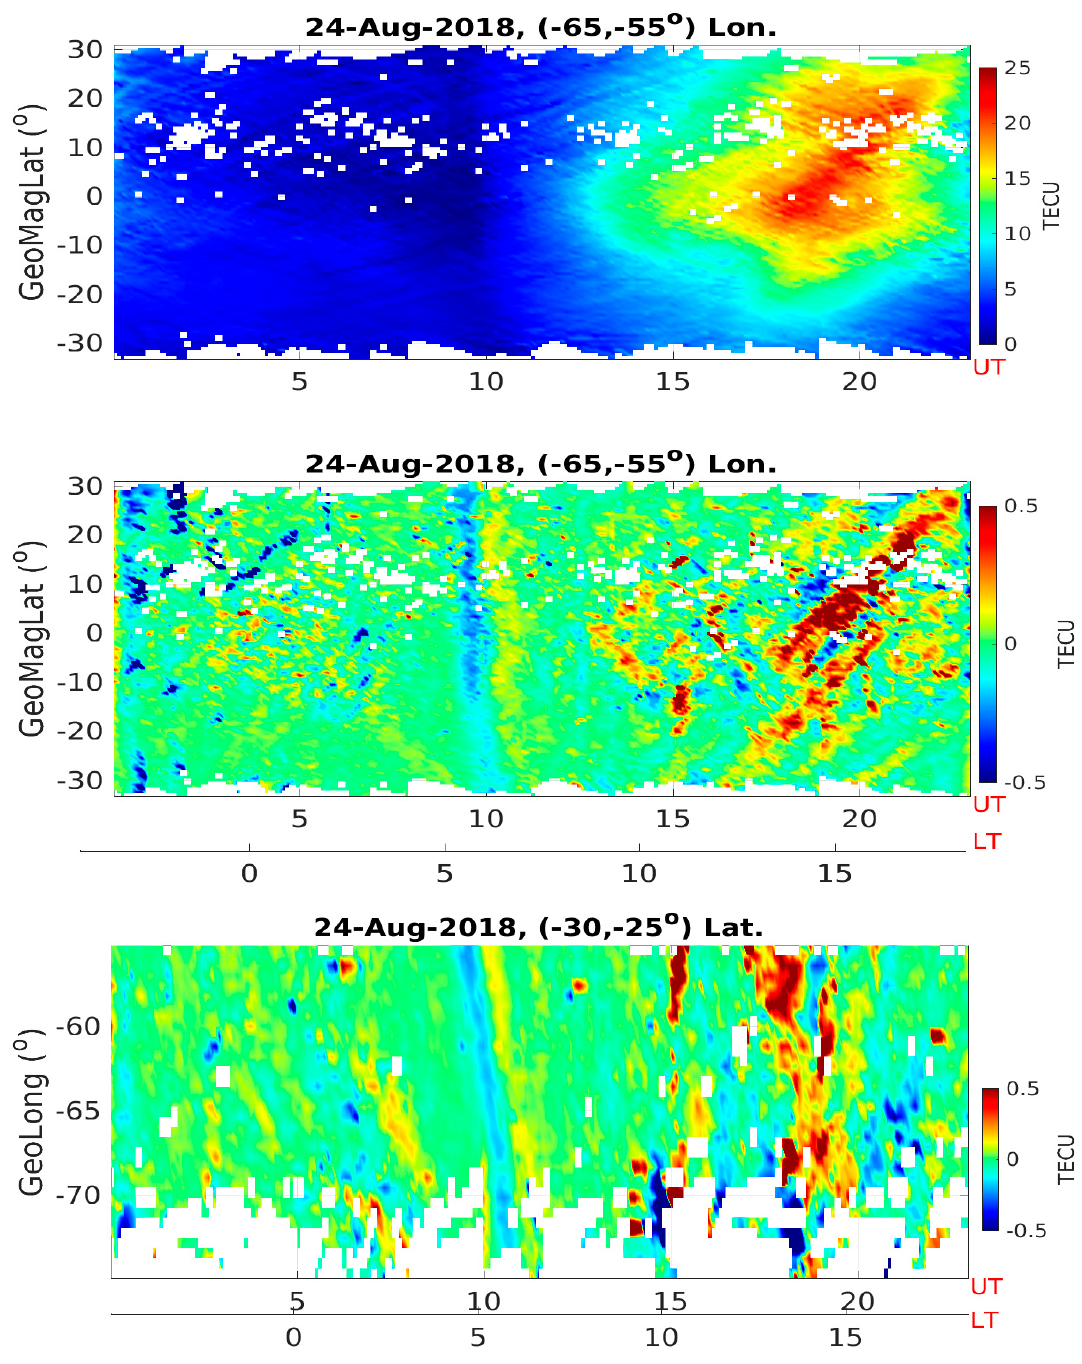
Figure 9. The same plots as Figure 8, but for 24 August 2018.